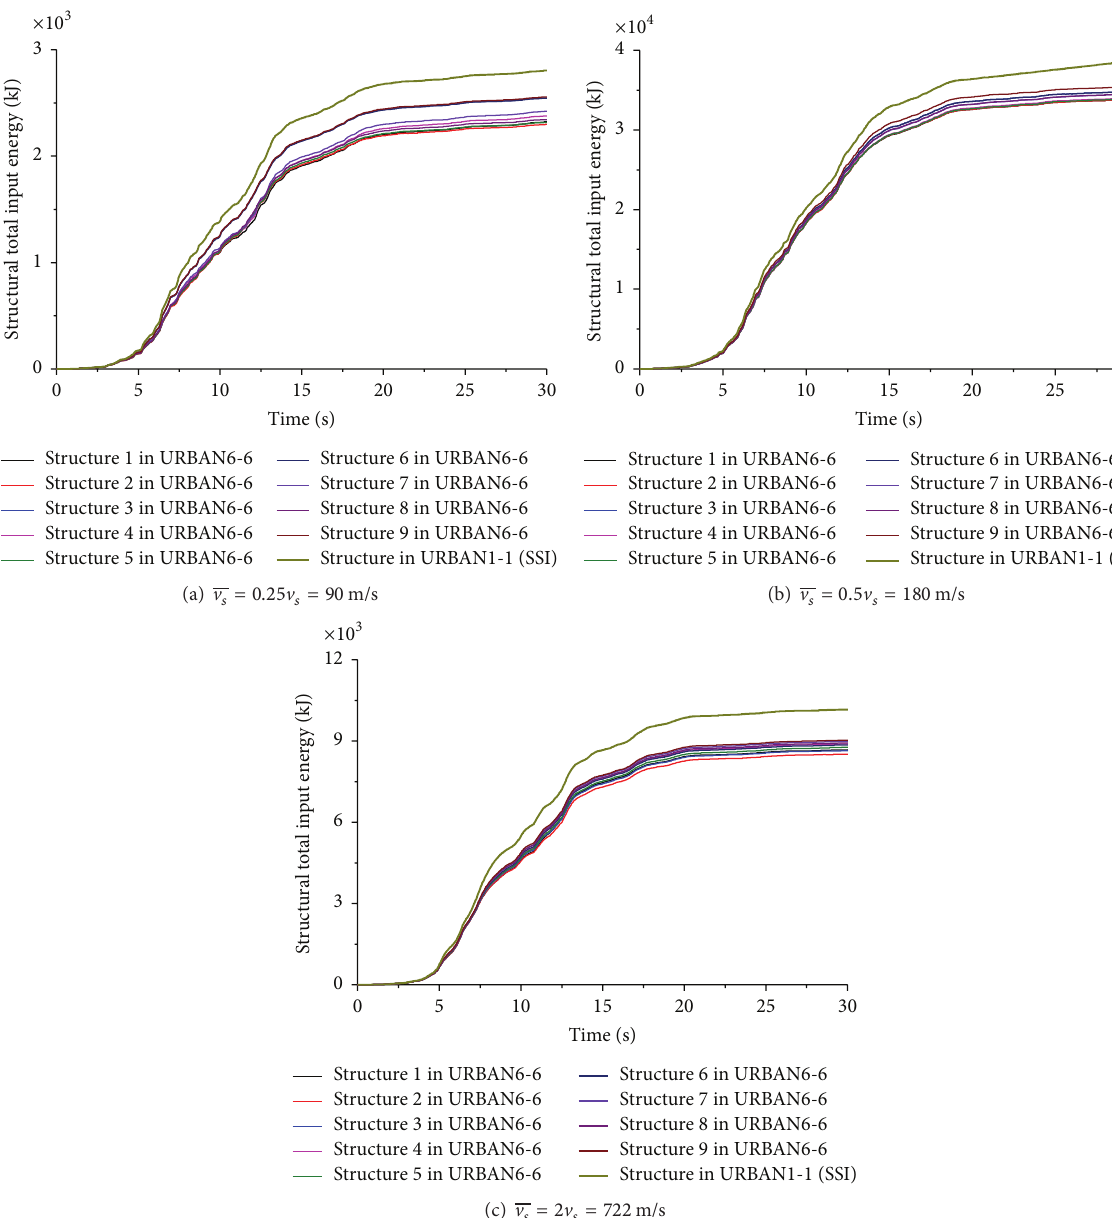
Figure 30: Structural total absorbed energy (URBAN6-6, 𝐷 = 0.5 , V 𝑠 = 𝑛 V 𝑠 , 𝑛 = 0.25, 0.5, 2 , MCH000, 𝑆𝑋